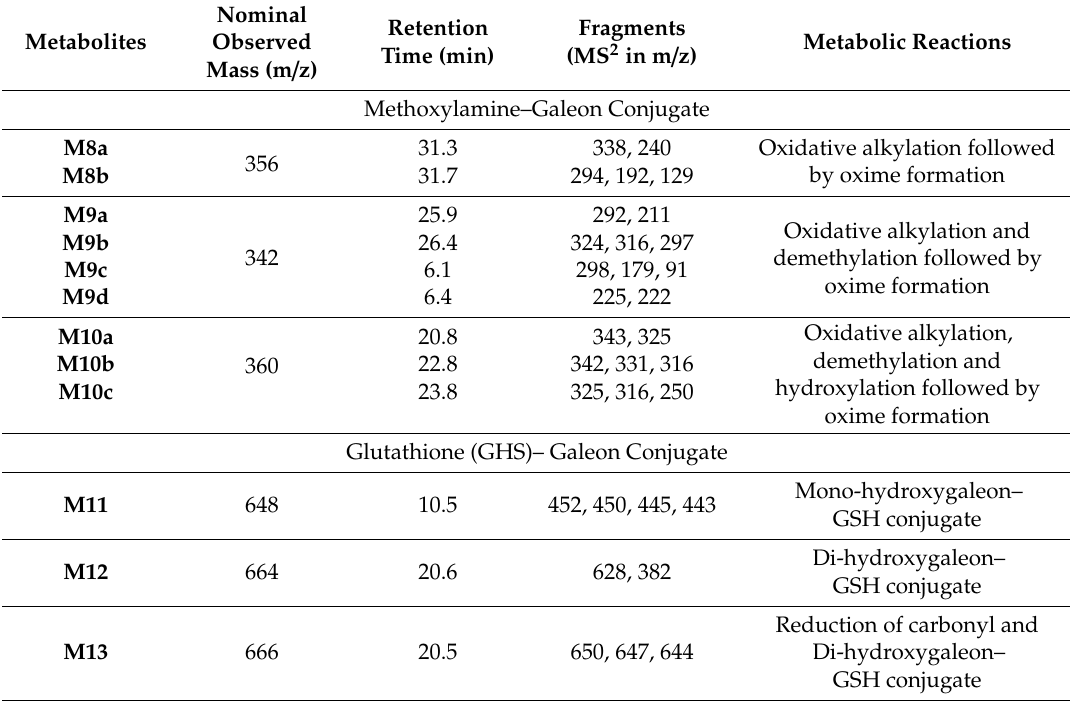
Table 3. Reactive metabolites of galeon .